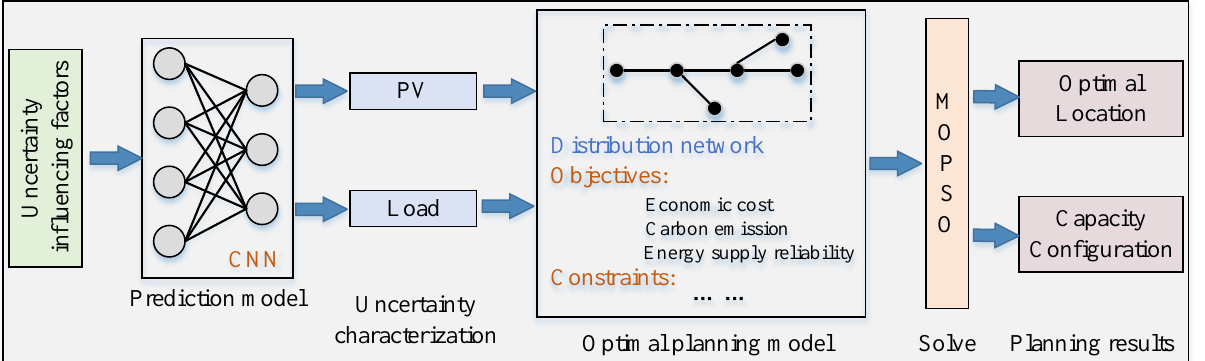
Figure 1. The overview of the proposed planning solution in DNs.